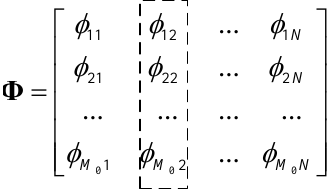
Figure 2. Explanation of node 2’s total coefficients